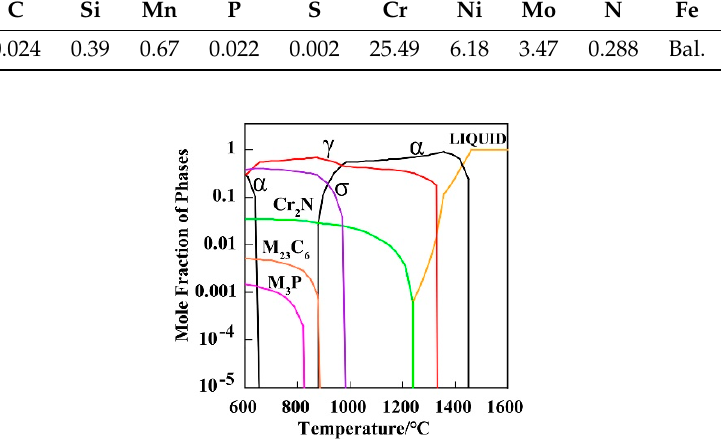
Figure 1. Equilibrium phase diagram of the UNS S32750 duplex stainless steel calculated by Thermo-calc software.